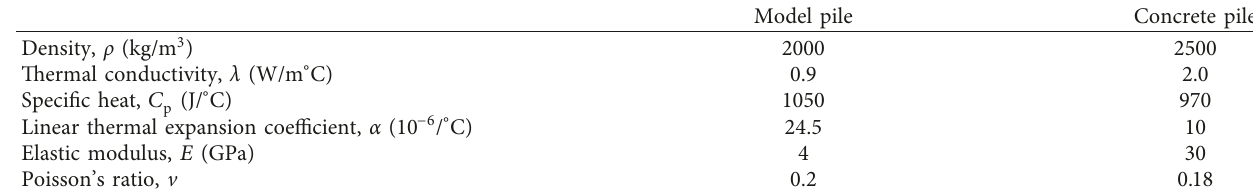
Table 1: Material parameters of piles.